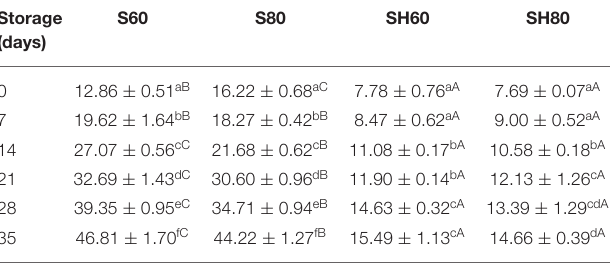
TABLE 2 | Peroxide value (meq kg − 1 ) during storage at 20 ◦ C. Storage (days)